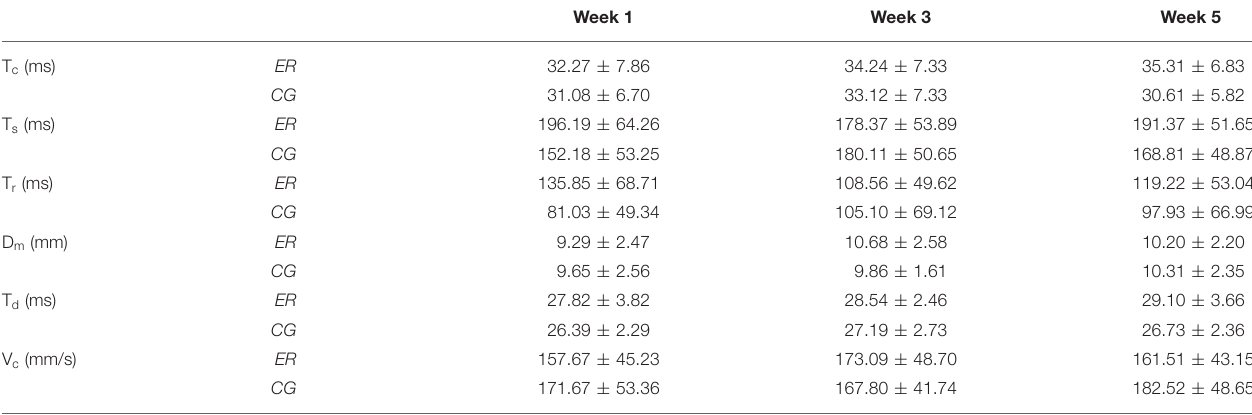
Supplementary Table 2 | Overview of the TMG analysis [energy-restricted (ER) and control group (CG)].